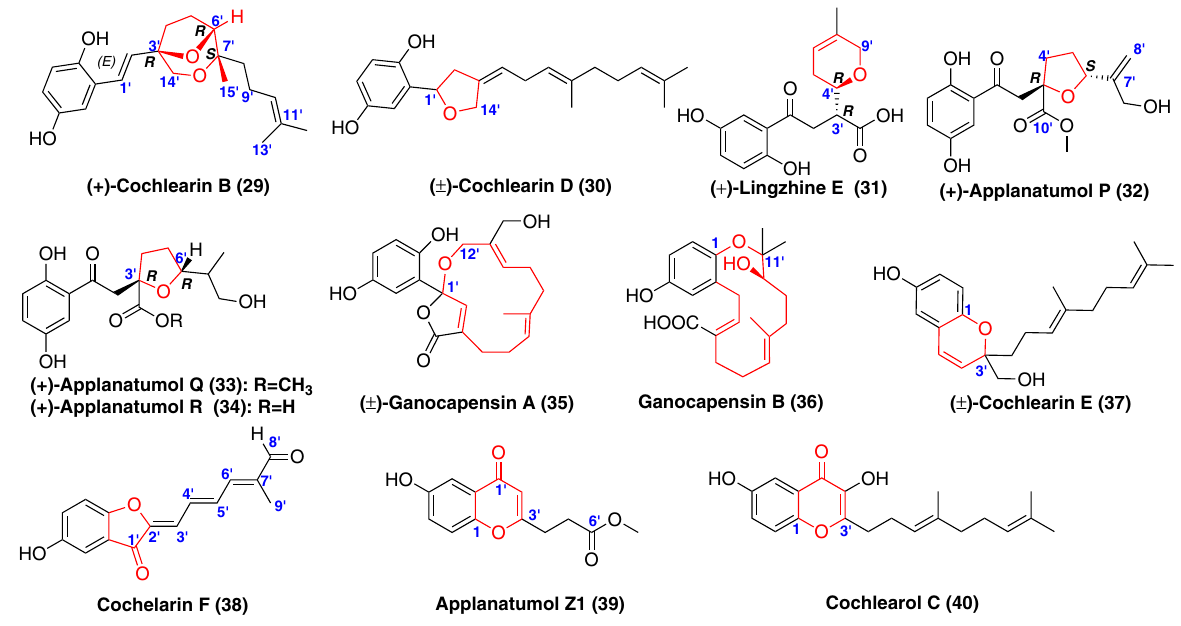
Fig. 4 Structures of GMs with an ether